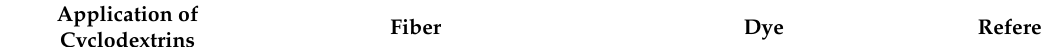
Table 2. Examples of dyeing CD applications, as a textile aid and as a chemical